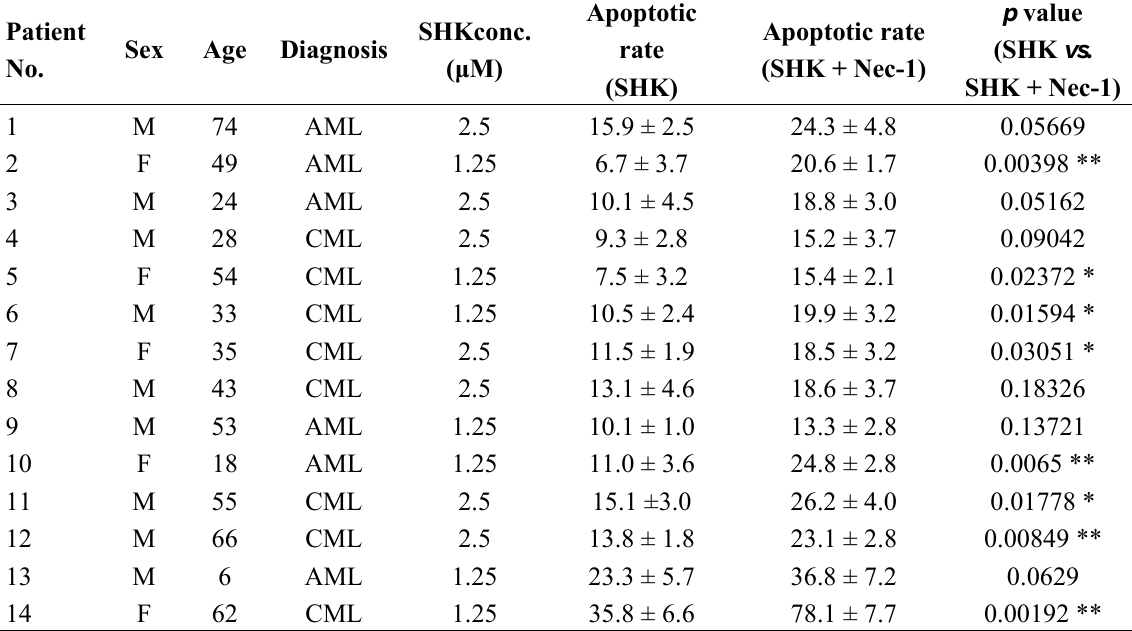
Table 1. Nec-1 enhances shikonin-induced apoptosis in primary leukemia